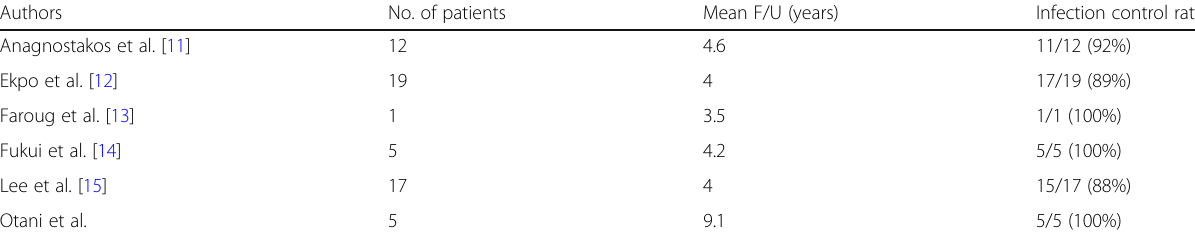
Table 1 Results of two-stage treatment with retention of well-fixed cementless stem